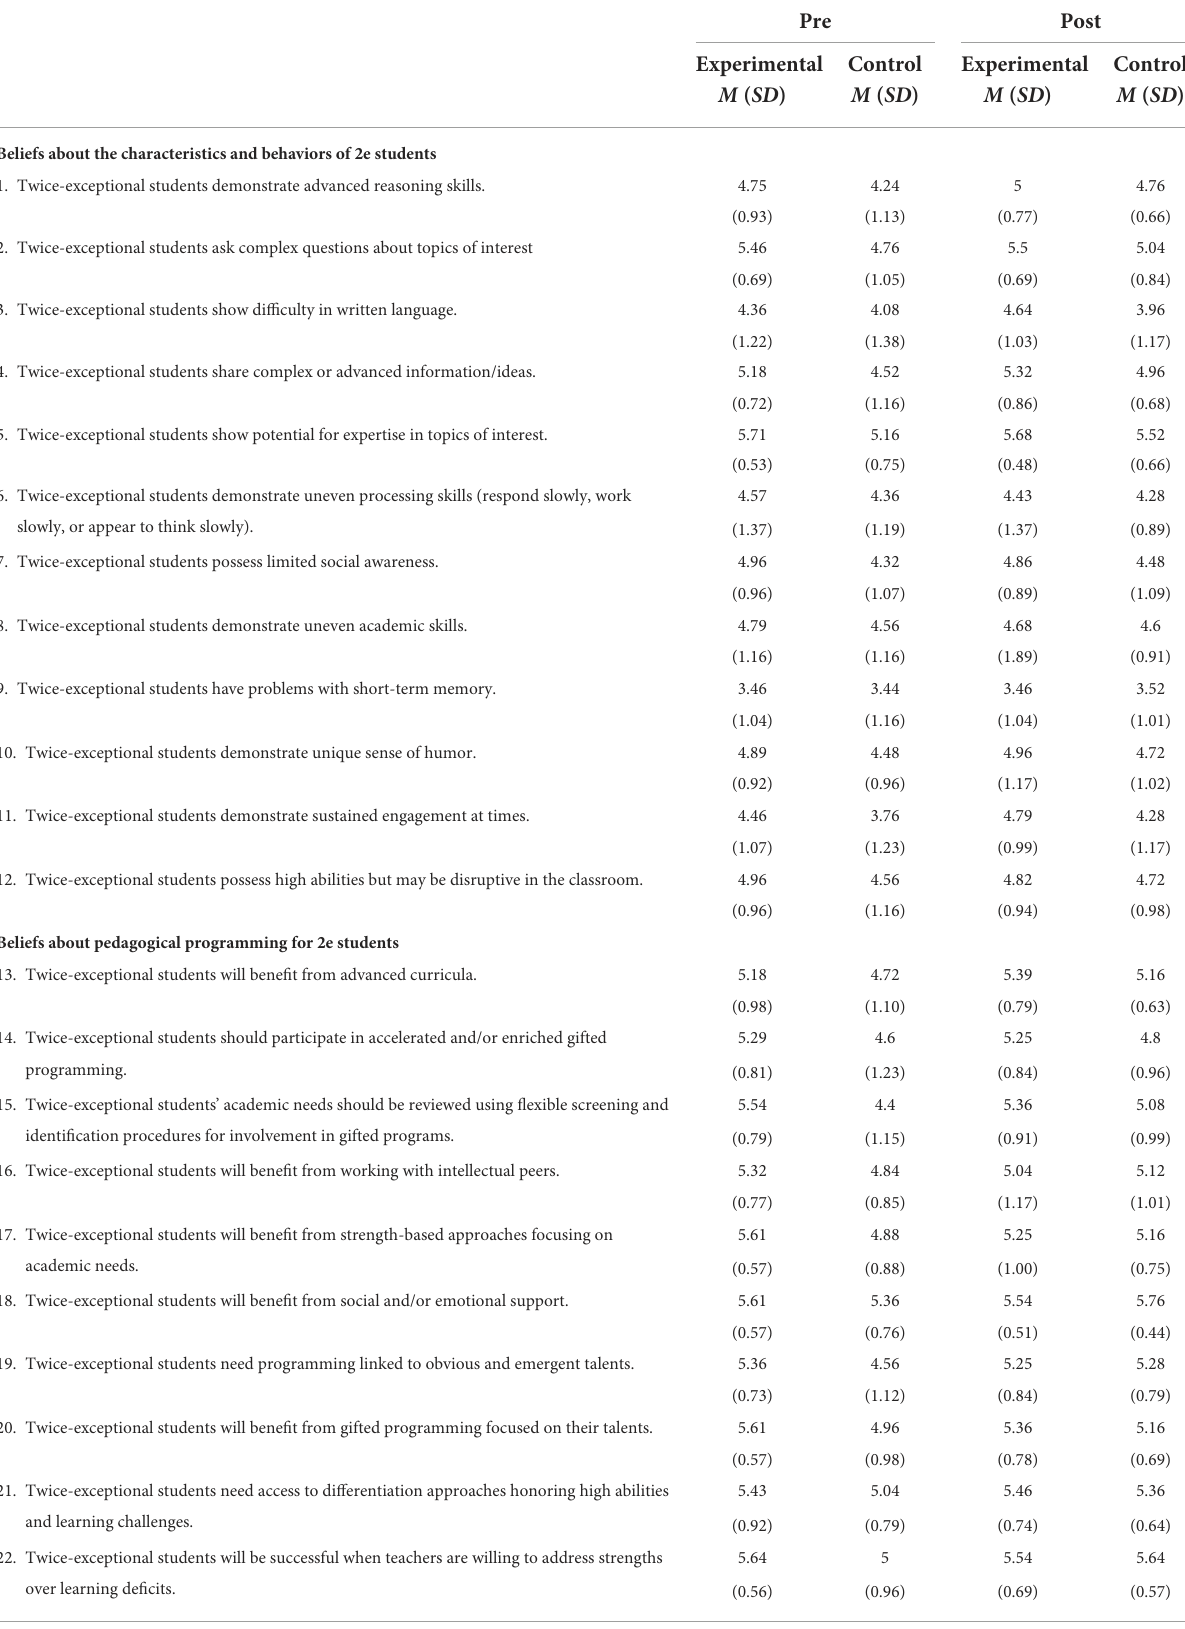
TABLE 1 Teachers’ beliefs about students identified as twice exceptional: item scores.